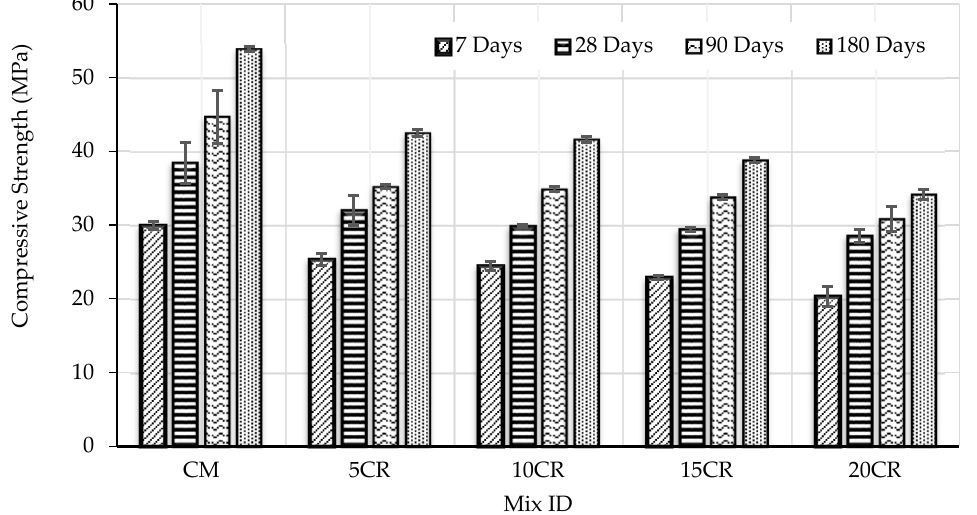
Figure 10. The average compressive strength of rubberized concrete.